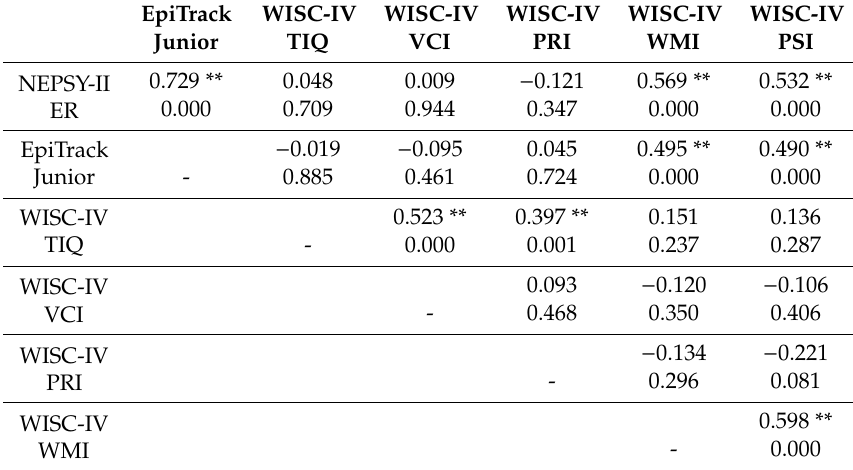
Table 3. Correlation between Nepsy-II (Emotion Recognition), EpiTrack Junior and WISC-IV